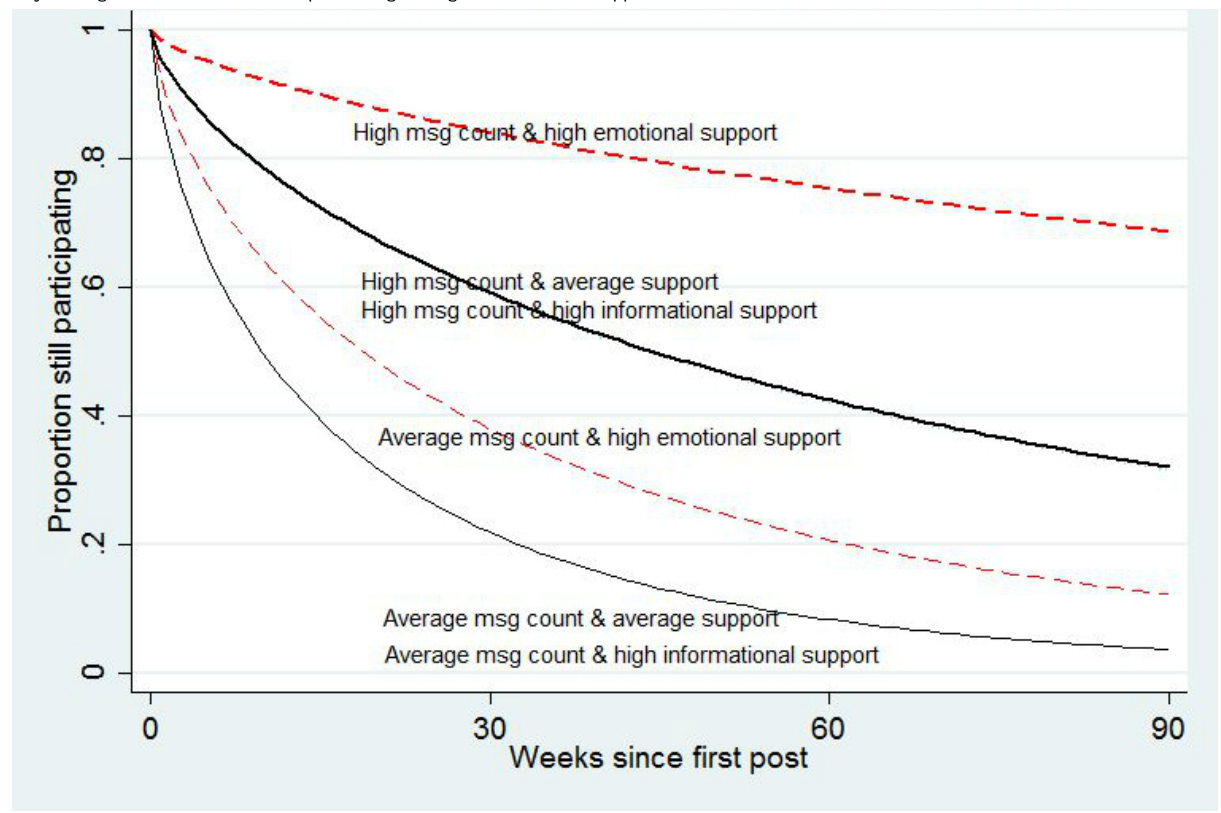
Figure 5. Survival curves for members exposed to different numbers of posts and type of social support. Note: although receiving more informational support was reliably associated with lower longevity on the site, the effect was small and the lines representing high informational support cannot be visually distinguished from the lines representing average informational